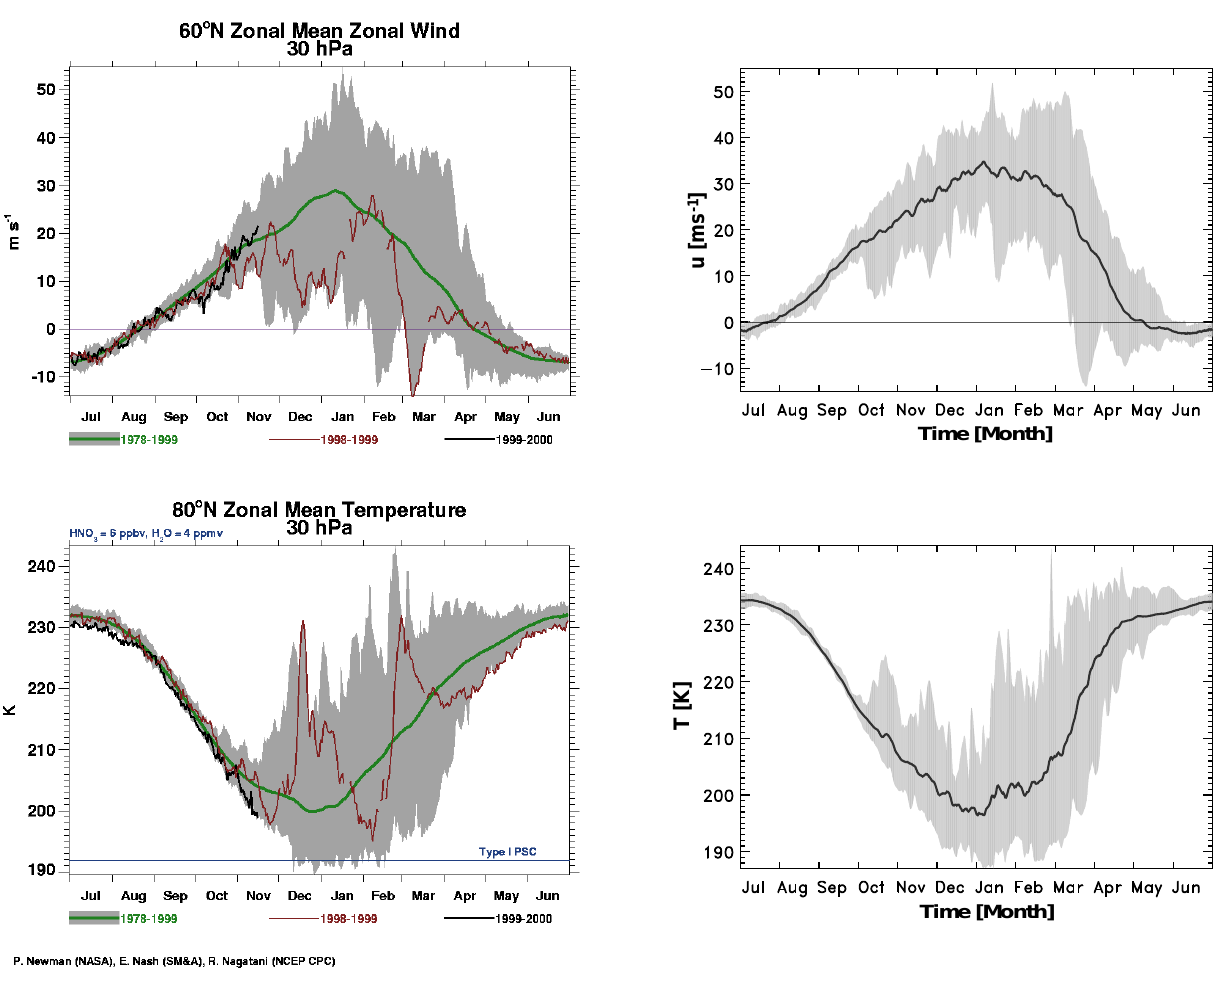
Fig. 3. Analyzed observed (left) and modeled (right) zonal means of the zonal wind at 60 ◦ N, 30 hPa (upper panels), and of the temperature at 80 ◦ N, 30 hPa (lower panels). NCEP analyses are based on observations from 1978–1998. Model data are averaged over 20 simulated years. Shaded areas indicate the interannual variability (minimum to maximum). Thin lines in the left panels represent analyses for the years 1998 and